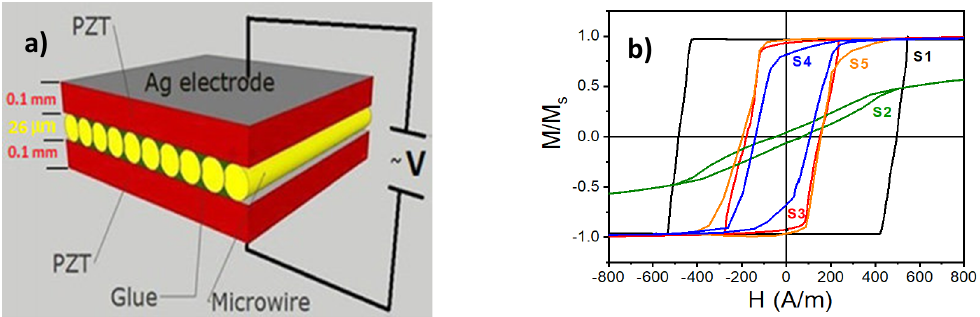
Figure 9. ( a ) The sketch of the structure of ME composites with microwires; ( b ) Hysteresis loops of individual microwires with composition of Fe 77.5 B 15 Si 7.5 in as-cast state (S1) and after different